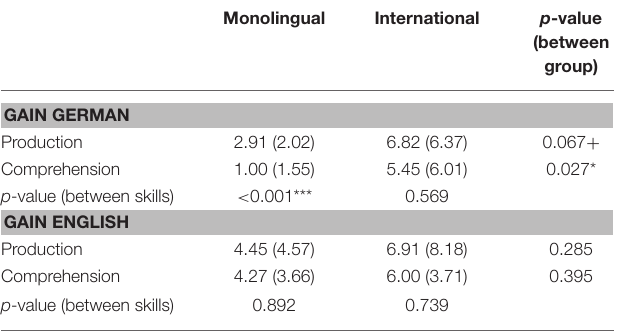
TABLE 3 | Means and standard deviations in parentheses for lexical gain per group, language and